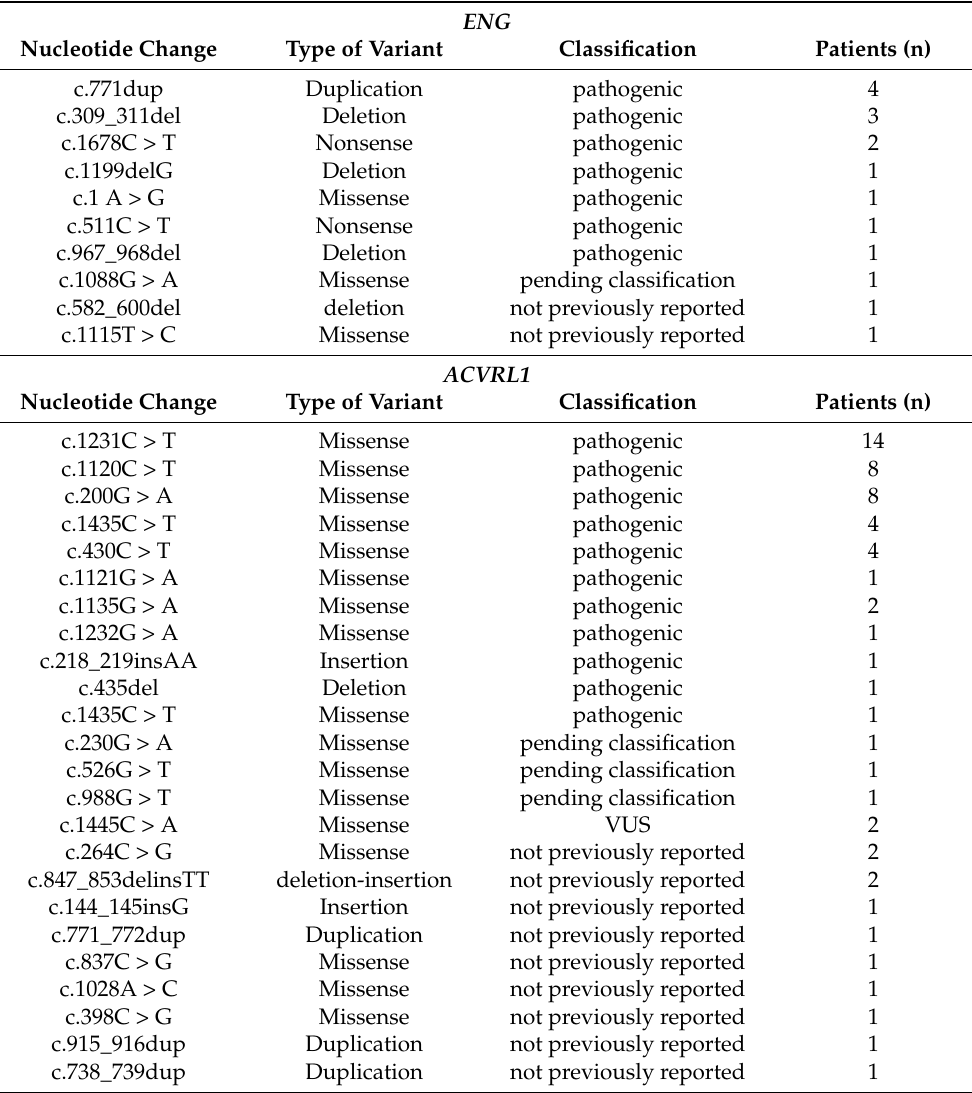
Table 2. Distribution of gene